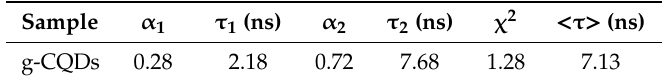
(EDA) =4 mL, T = 180 °C, D r =